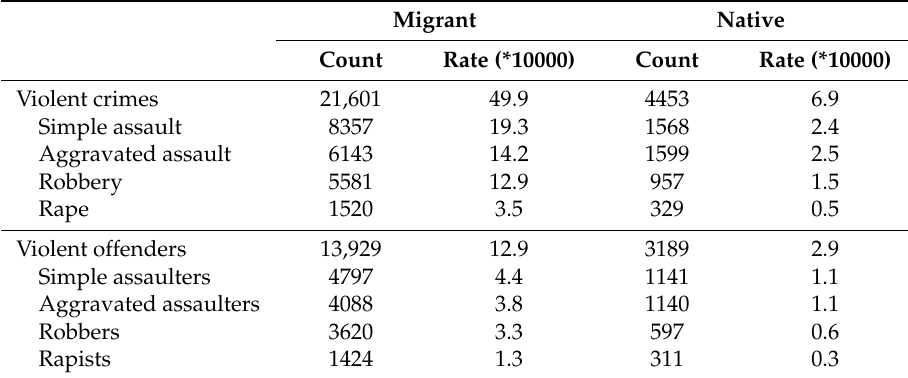
Table 1. Descriptive statistics of crimes and offenders by migrant and native residents.